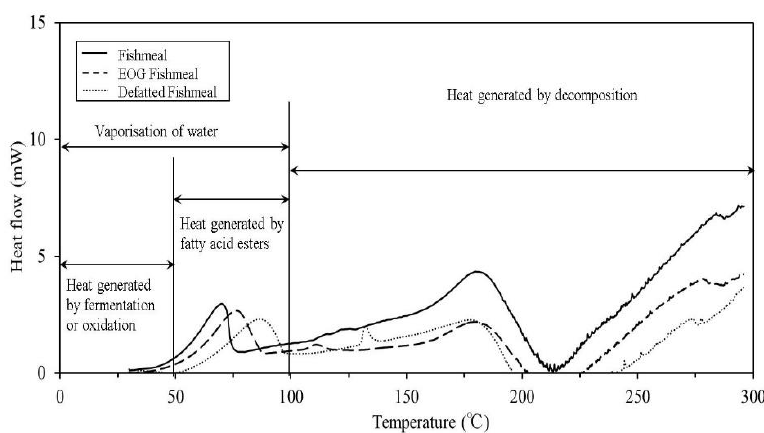
Figure 9. C80-calorimetry results for fishmeal.